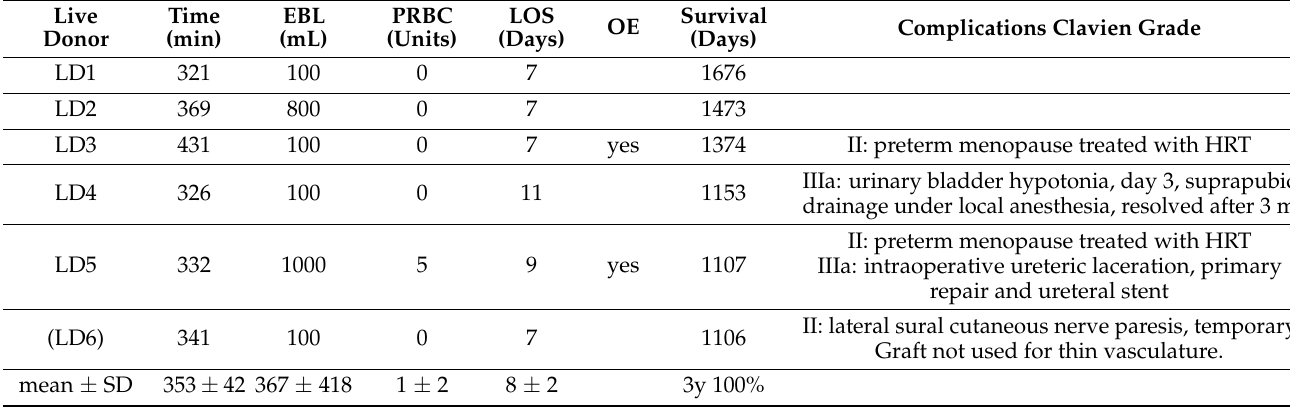
Table 4. Operative details and post-operative complications of live donors of uterine grafts. All surgeries were open laparotomy